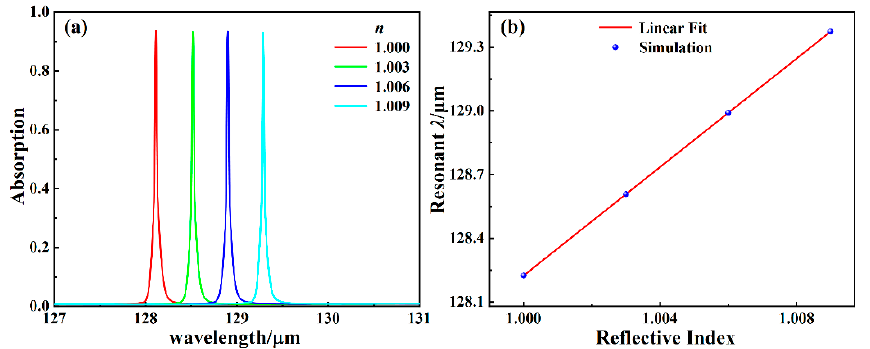
Table 1. Comparisons of Q -factor and FOM among designs in previous works.